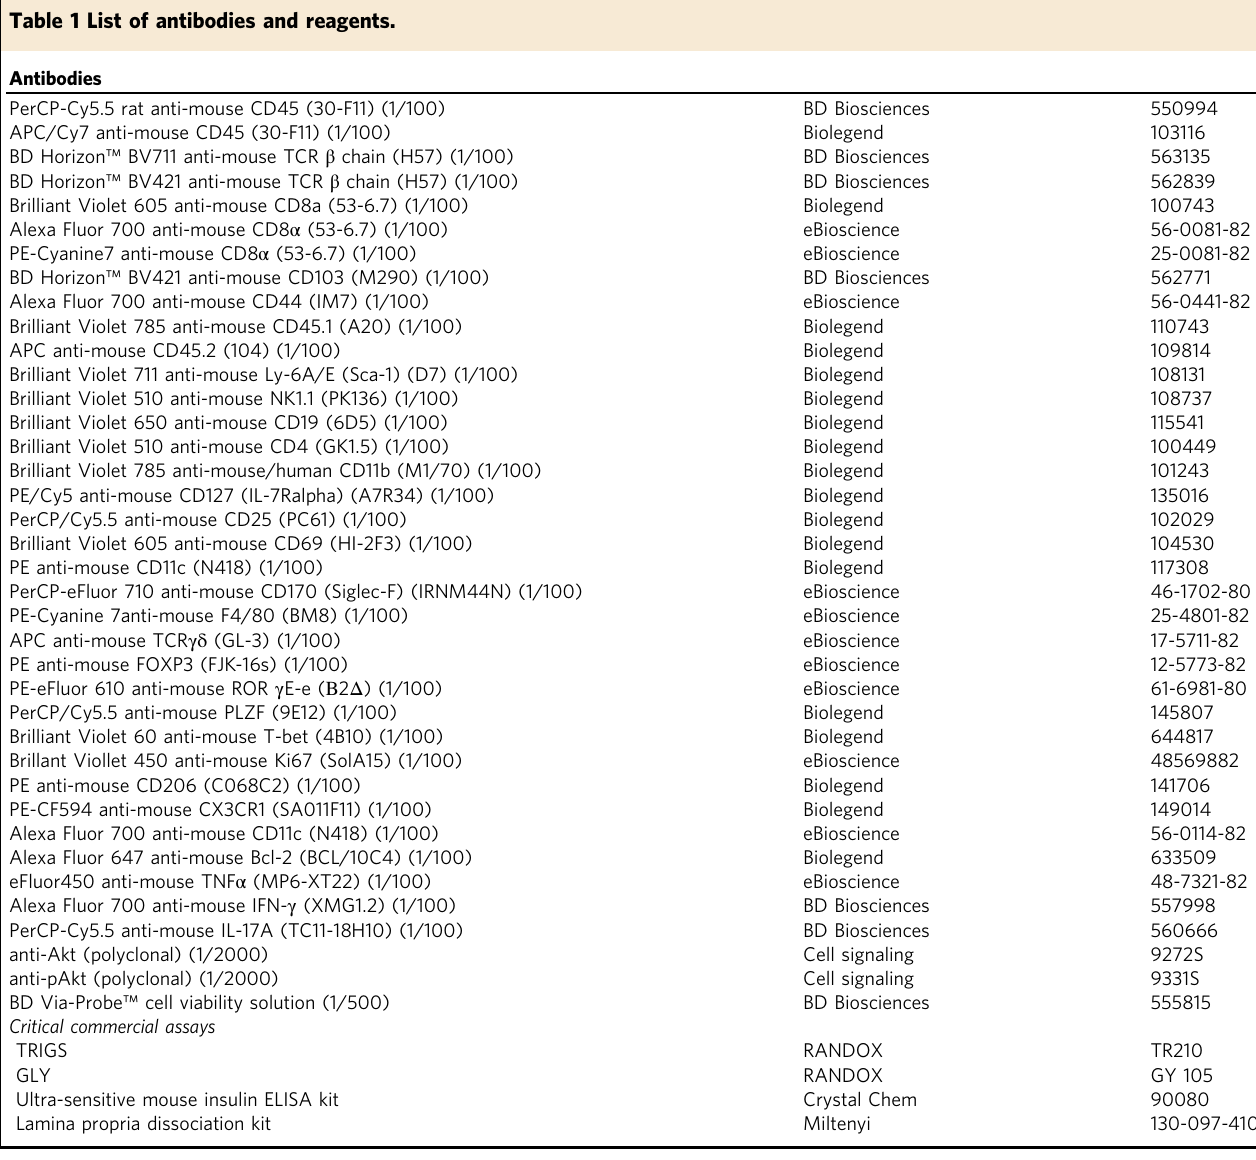
Table 1 List of antibodies and